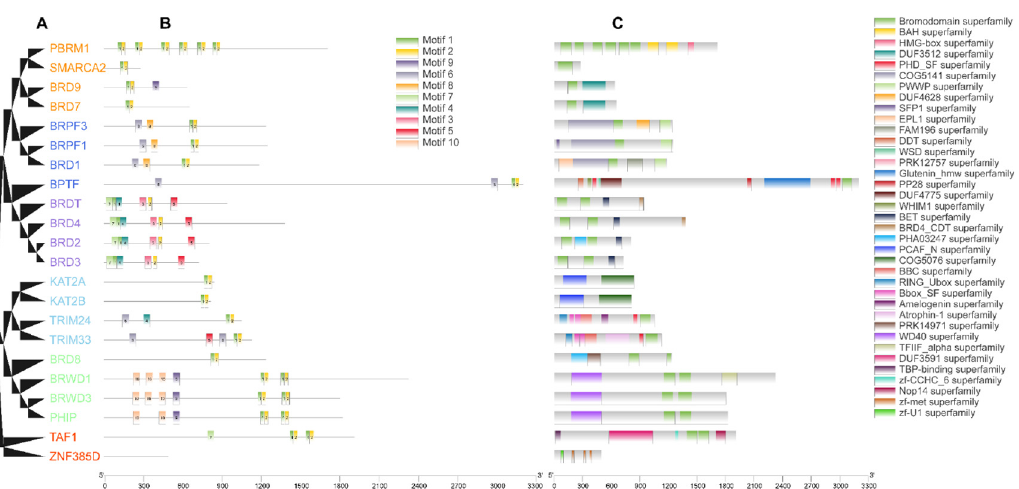
Figure 2. Evolutionary relationships, motif pattern, and conserved domains of BRD protein family in buffalo. ( A ) Phylogenetic tree of 22 BRD proteins. ( B ) Motif pattern of BRD proteins. Ten presumptive motifs are indicated with boxes marked different colors. Refer to Table 1 for more information of the motifs. ( C ) Distributions of conserved domains in BRD proteins.